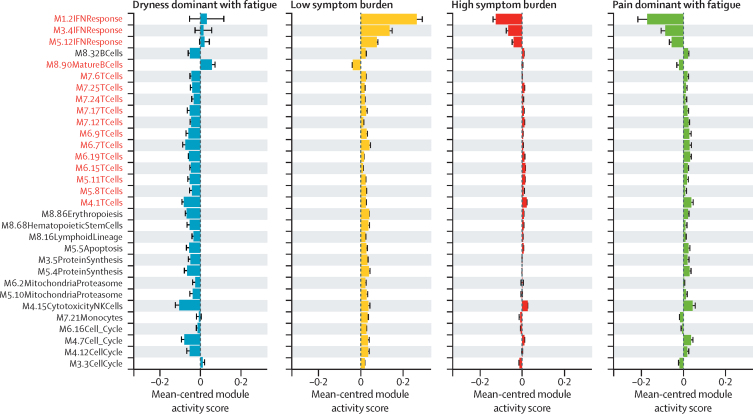
Chaussabel module activity scores adjusting for batch differences for the UKPSSR and ASSESS transcriptomics datasets centred on the mean for each module. Shown are the top 31 modules with significant differences between subgroups in the UKPSSR and ASSESS cohorts. Negative values imply inhibition and positive values imply activation. The error bars represent 95% CIs. For example, the first module is activated in patients in the dryness dominant with fatigue and low symptom burden subgroups, but inhibited in patients in the high symptom burden. and pain dominant with fatigue subgroups. Of particular interest are the modules IFN Response, mature B cells, and T cells (highlighted red). Unadjusted p values were used in this analysis. Details of the modules including the adjusted p values are listed in the appendix (p 17). IFN=interferon.